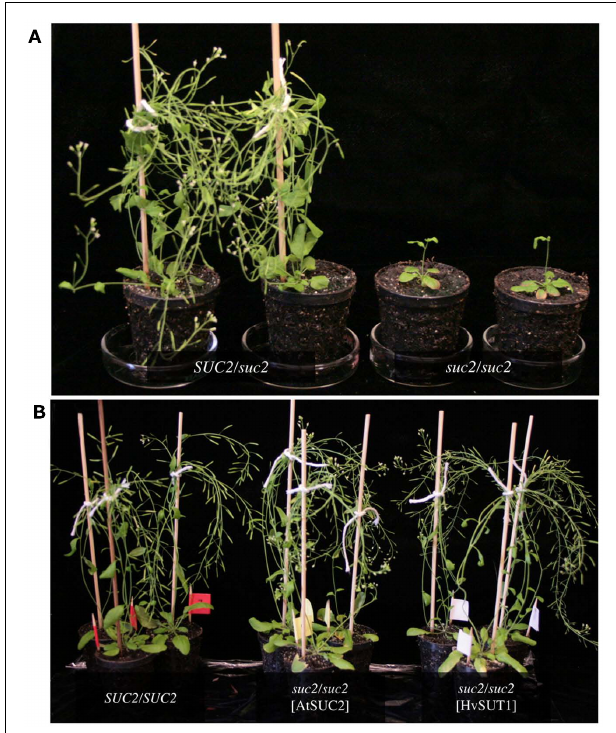
FIGURE 3 | Complementation of suc2-1 sucrose transporter mutant. (A) Arabidopsis plants heterozygous for the suc2-1 insertion left, plants homozygous for the suc2-1 insertion right. (B) Both AtSUC2 and HvSUT1 complemented the growth defect of the homozygous suc2-1 mutant.The WS wild-type (left) is shown for comparison. All plants shown in (A) and (B) are 8weeks